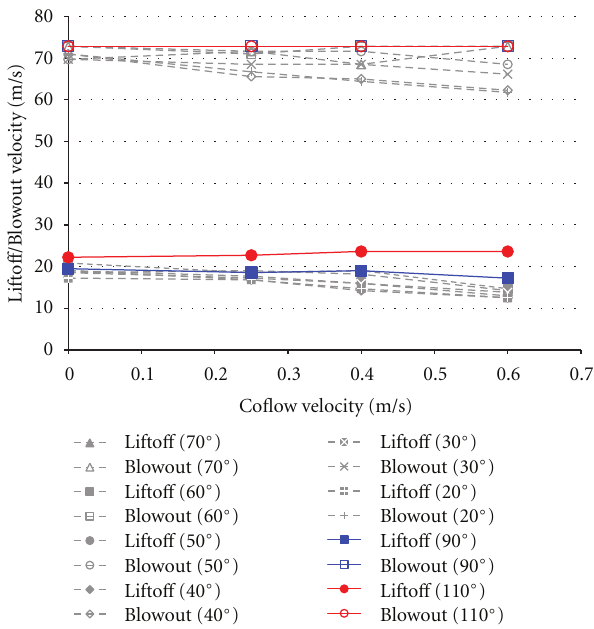
90 ◦ and 110 ◦ angles, which are higher and remain nearly constant regardless of coflow velocity. Though changes in blowout velocity could not be determined, the actual